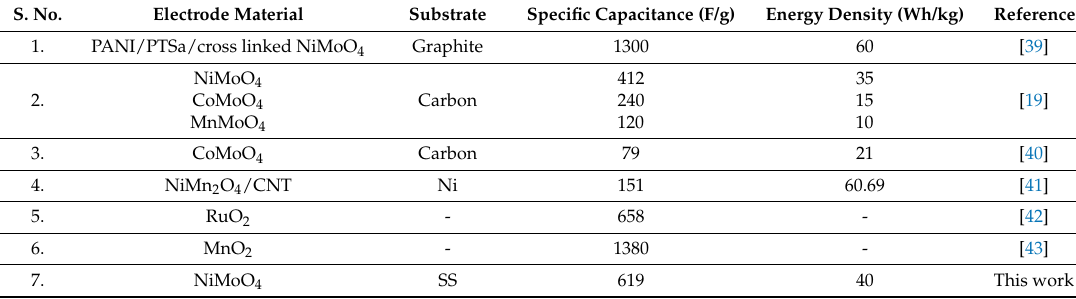
Table 2. Electrochemical performance of this work compared with previously reported various metal oxide supercapacitor electrode materials.